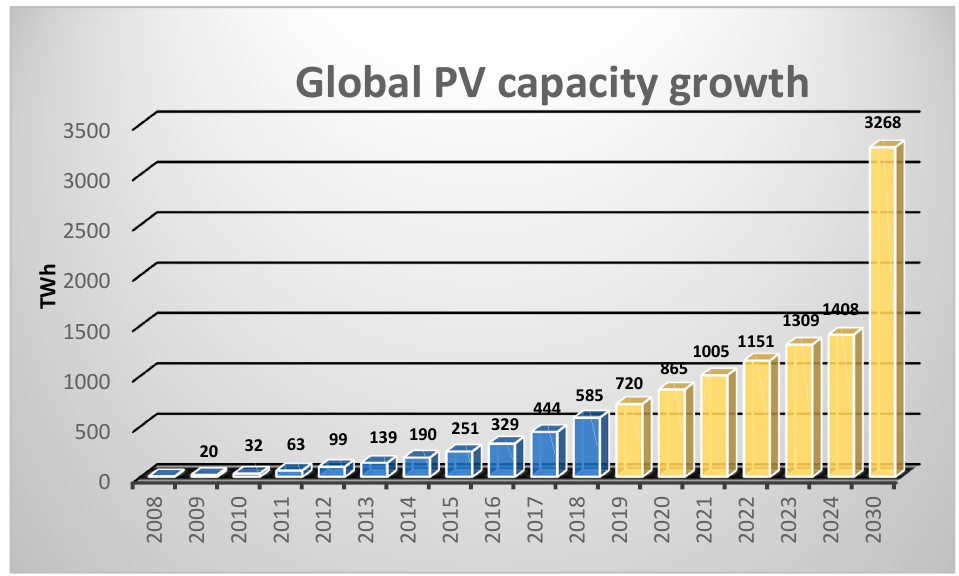
Figure 1. Installed global solar photovoltaic (PV) capacity [7].